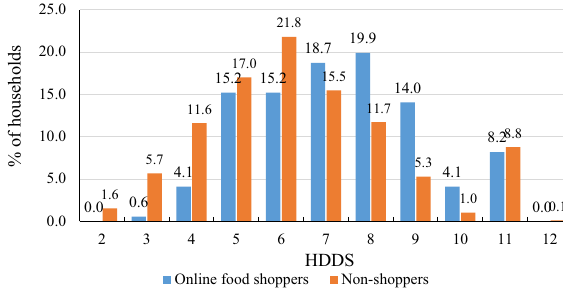
Fig. 1 Distributions of dietary diversity scores by online food shopping